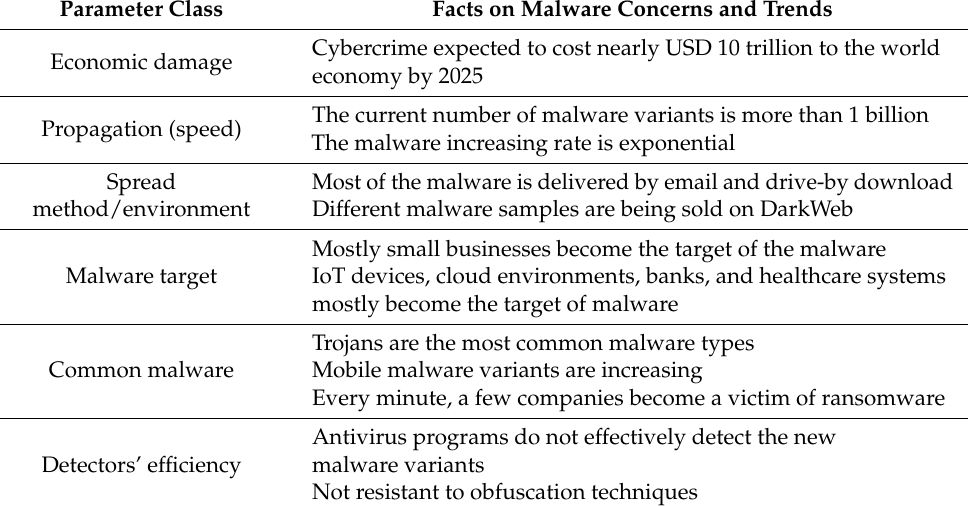
Table 1. Recent malware concerns and trends. Parameter Class Facts on Malware Concerns and Trends Cybercrime expected to cost nearly USD 10 trillion to the world Economic damage economy by 2025 The current number of malware variants is more than 1 billion Propagation (speed) The malware increasing rate is exponential Spread Most of the malware is delivered by email and drive-by download method/environment Different malware samples are being sold on DarkWeb Mostly small businesses become the target of the malware Malware target IoT devices, cloud environments, banks, and healthcare systems mostly become the target of malware Trojans are the most common malware types Common malware Mobile malware variants are increasing Every minute, a few companies become a victim of ransomware Antivirus programs do not effectively detect the new Detectors’ efficiency malware variants Not resistant to obfuscation